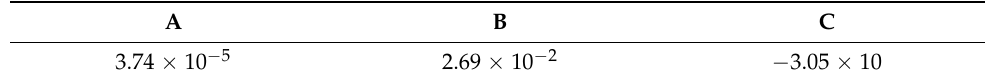
Table 4. Propeller curve parameters.